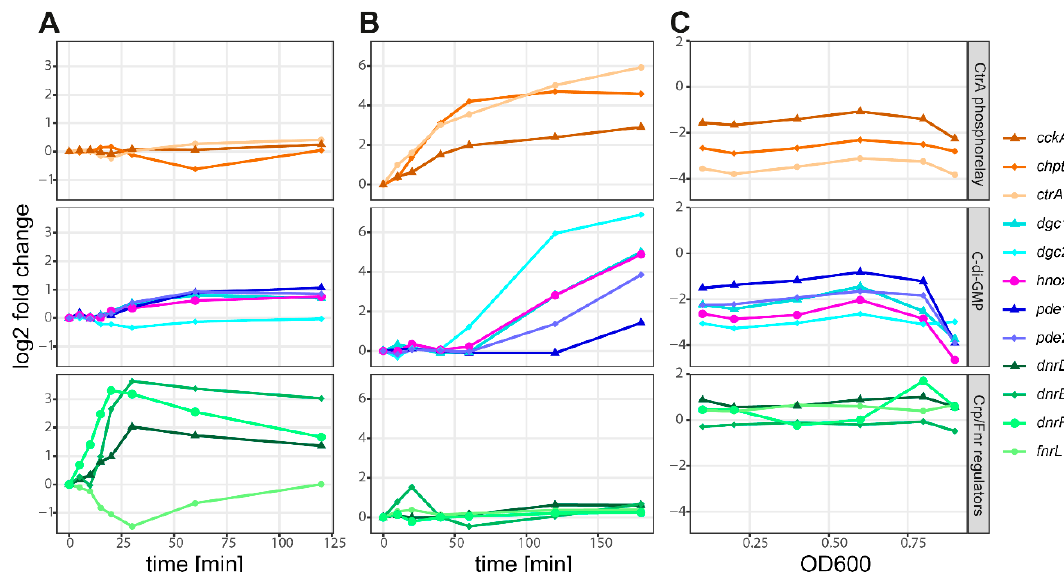
Figure 4. Time- and density-resolved transcript levels in three different conditions for three groups of regulators. The expression profiles of the CtrA phosphorelay genes (top), c-di-GMP signaling genes (middle), and four Crp/Fnr regulator-encoding genes (bottom) are plotted. The changes in transcript levels were monitored after the switch from aerobic to anaerobic growth over a time period of 120 min ( A ), after the external addition of autoinducer (3-oxo C14 HSL) to the synthase null mutant ( ∆ luxI 1 ) over a period of 180 min ( B ), and during logarithmic (samples 1–5) and stationary (sample 6) phases of growth as determined by optical density ( C ).